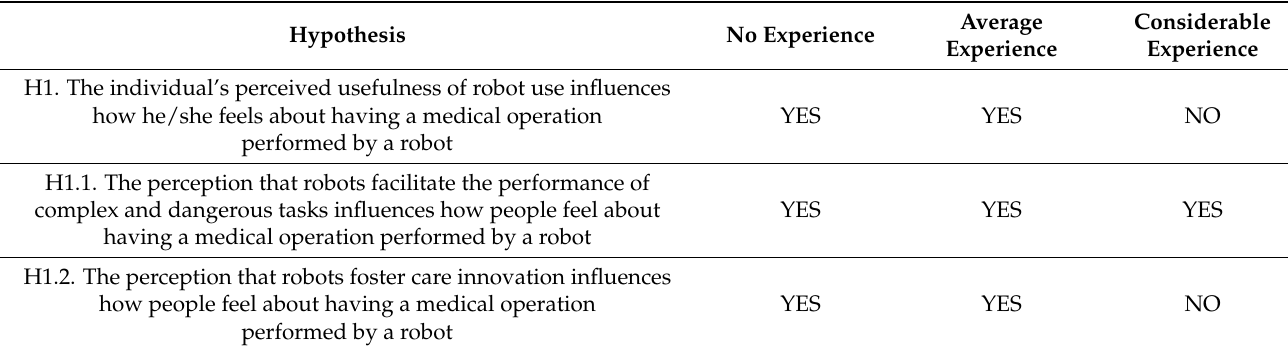
Table A2. Degree of fulfilment of the